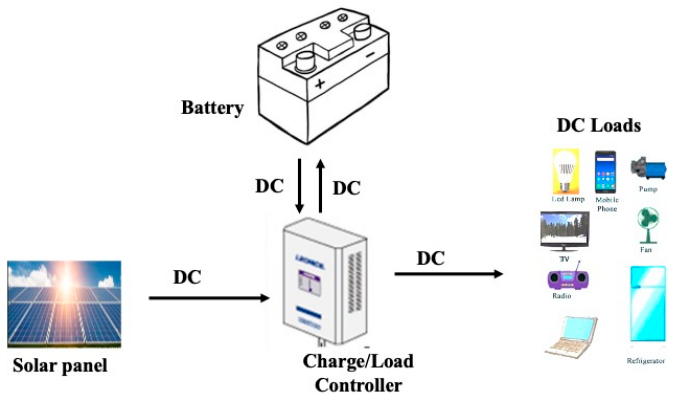
Figure 5. Typical schematic of off-grid DC microgrid.